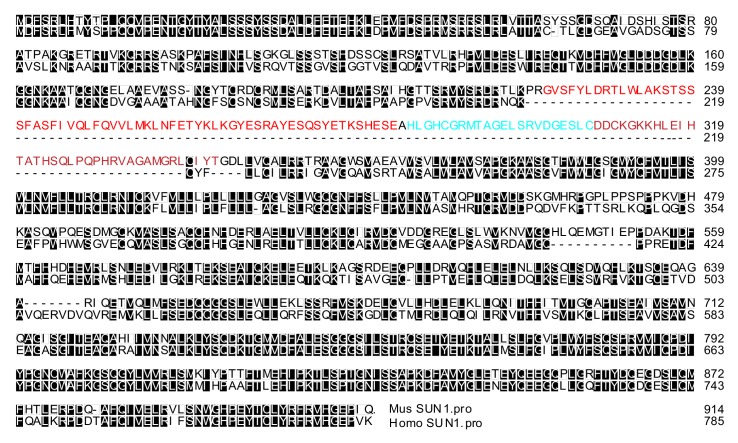
Amino acid sequence alignment of mouse SUN1 and human SUN1Δ6.The mouse SUN1 exon 7 to 9 sequences are color coded and are not conserved in the human SUN1 gene.